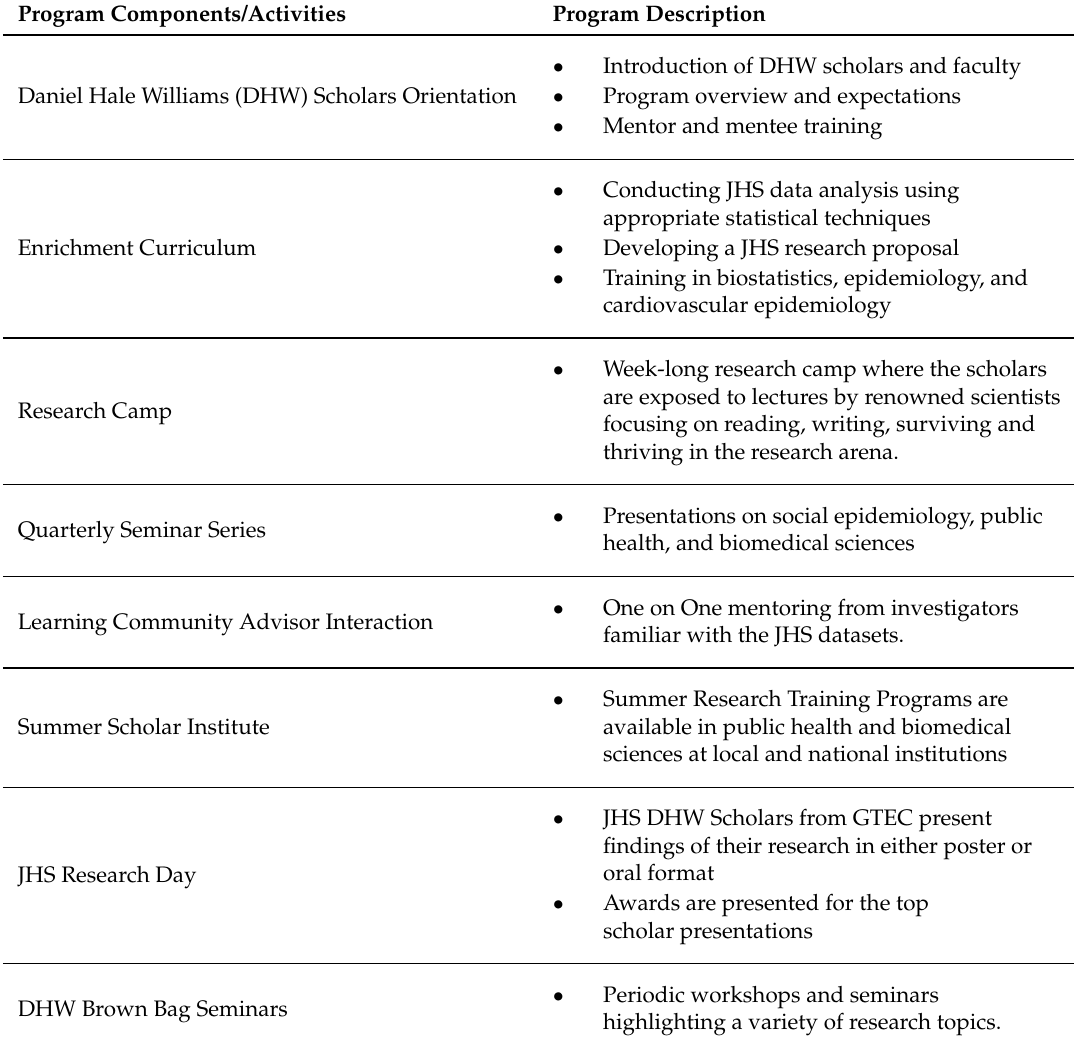
Table 3. Program Components and Activities of the DHWS